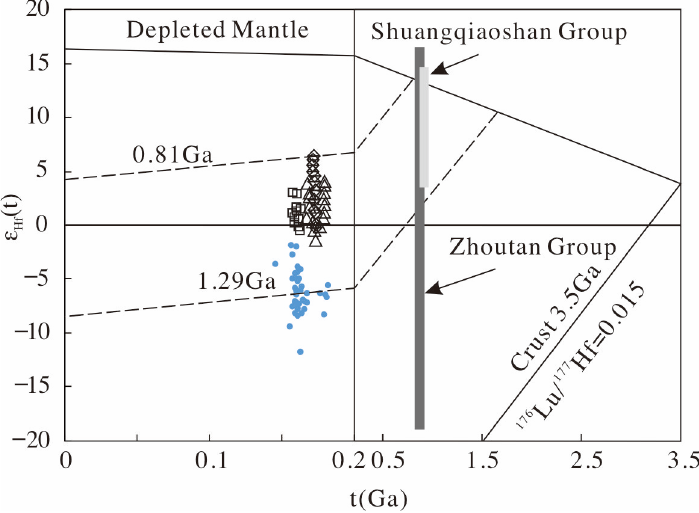
Figure 11. ε Hf (t) vs. U-Pb ages diagram for the Dongxiang intrusive rocks [21,38,70]. The dashed lines of crustal extraction were calculated using an 176 Lu/ 177 Hf ratio of 0.015 as an average for the continental crust using data from Griffin, et al. 2002 [38]. The data of the Shuangqiaoshan Group and Zhoutan Group are from Li, et al. 2009 [70]. The data of Dexing, Yinshan and Jiande are from Wang, et al. 2006 [21]. Symbols are the same as in Figure 10.